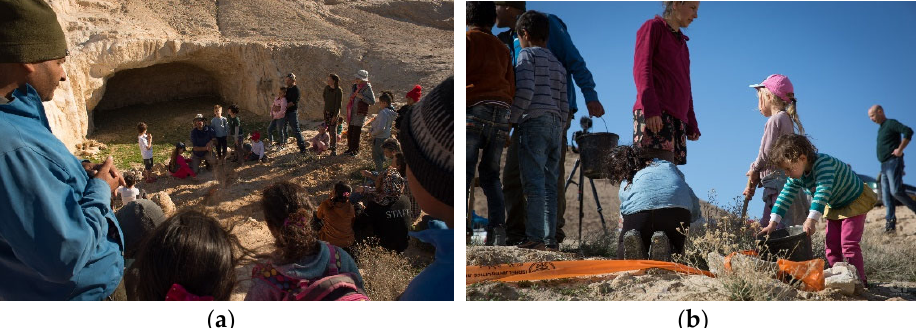
Figure 9. ( a , b ) Schoolchildren with IAA archeologist in the second socially engaged act at Bir Umm al Atin Cistern ( a ) receiving instruction in preparation for their work, and ( b ) clearing buildup of earth from the cistern, February 2020. Photographed by Dan Farberoff. Images courtesy of the artist.